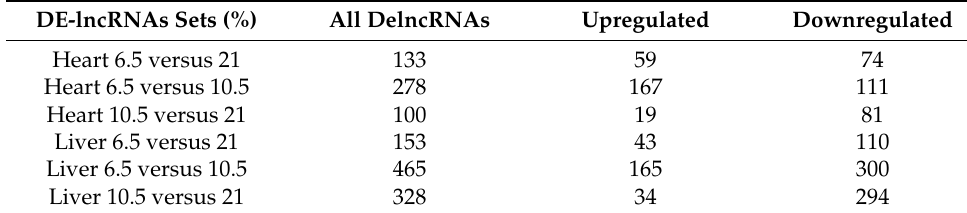
Figure 2. Characteristics of lncRNAs. ( A ) Length distribution of 4877 lncRNAs and 19,009 mRNAs. The X -axis represents the length and the Y -axis represents the number of lncRNAs and mRNAs with specific lengths. ( B ) The GC content distribution of lncRNAs and mRNAs. ( C ) The distribution of the expression levels for lncRNAs and mRNAs across different groups. ( D ) The organ distribution of lncRNAs and mRNAs with peak expression levels. LncRNAs: Long noncoding RNAs; mRNAs: messenger RNAs; GC content: the ratio of guanine plus cytosine, GC content percentage was calculated as Count (G + C)/Count (A + T + G + C) * 100%. FPKM: Fragments Per Kilobase of transcript per Million mapped reads; He06: heart tissue under 6.5% O 2 concentration; He10: heart tissue under 10.5% O 2 concentration; He21: heart tissue under 21% O 2 concentration; Lv06: liver tissue under 6.5% O 2 concentration; Lv10: liver tissue under 10.5% O 2 concentration; Lv21: liver tissue under 21% O 2 concentration. Table 2. DE-lncRNA